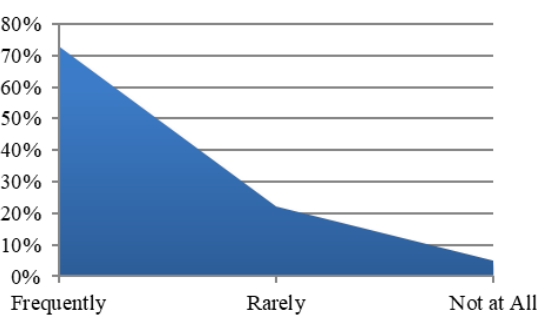
Figure 3. Hazardous impact of various components on environment